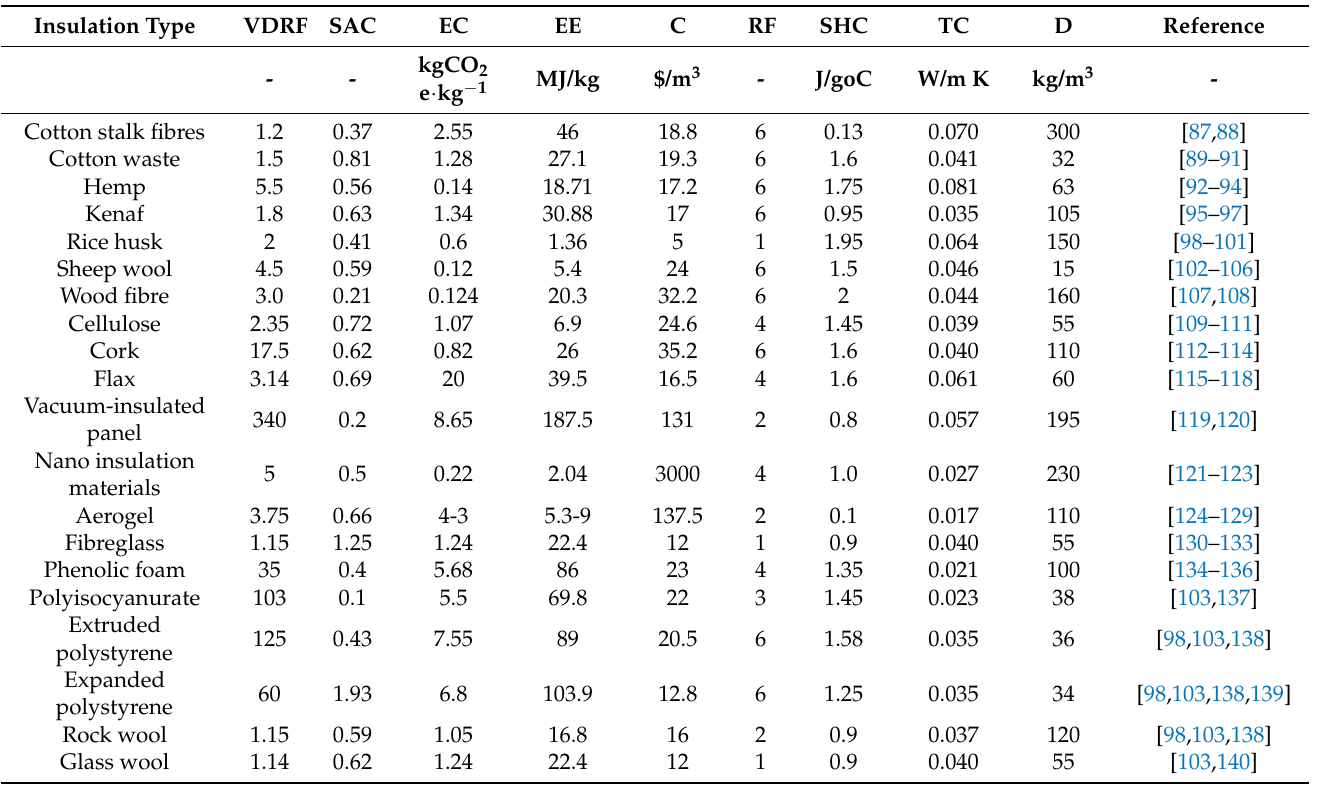
Table 4. Insulation materials commonly used in commercial buildings